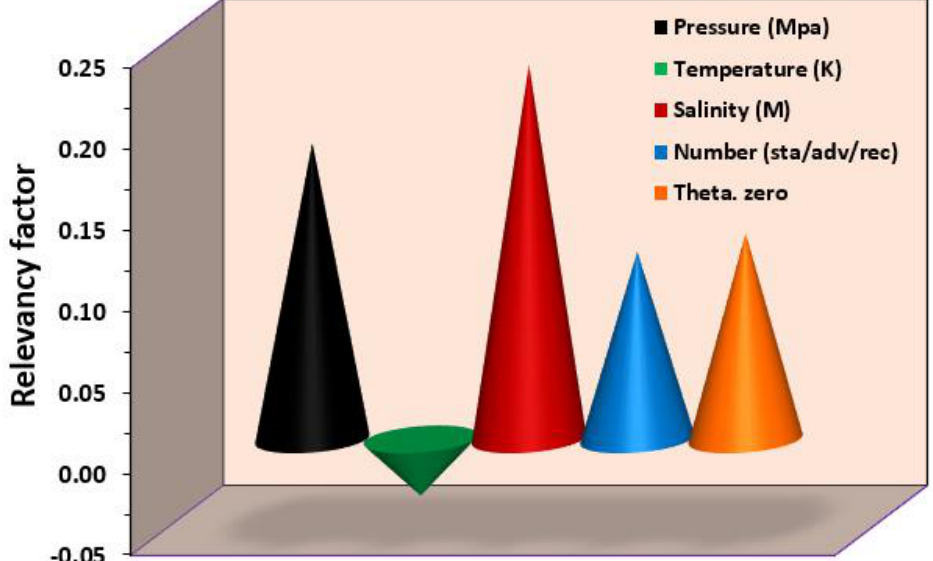
Figure 13. Sensitivity analysis on contact angle behavior.